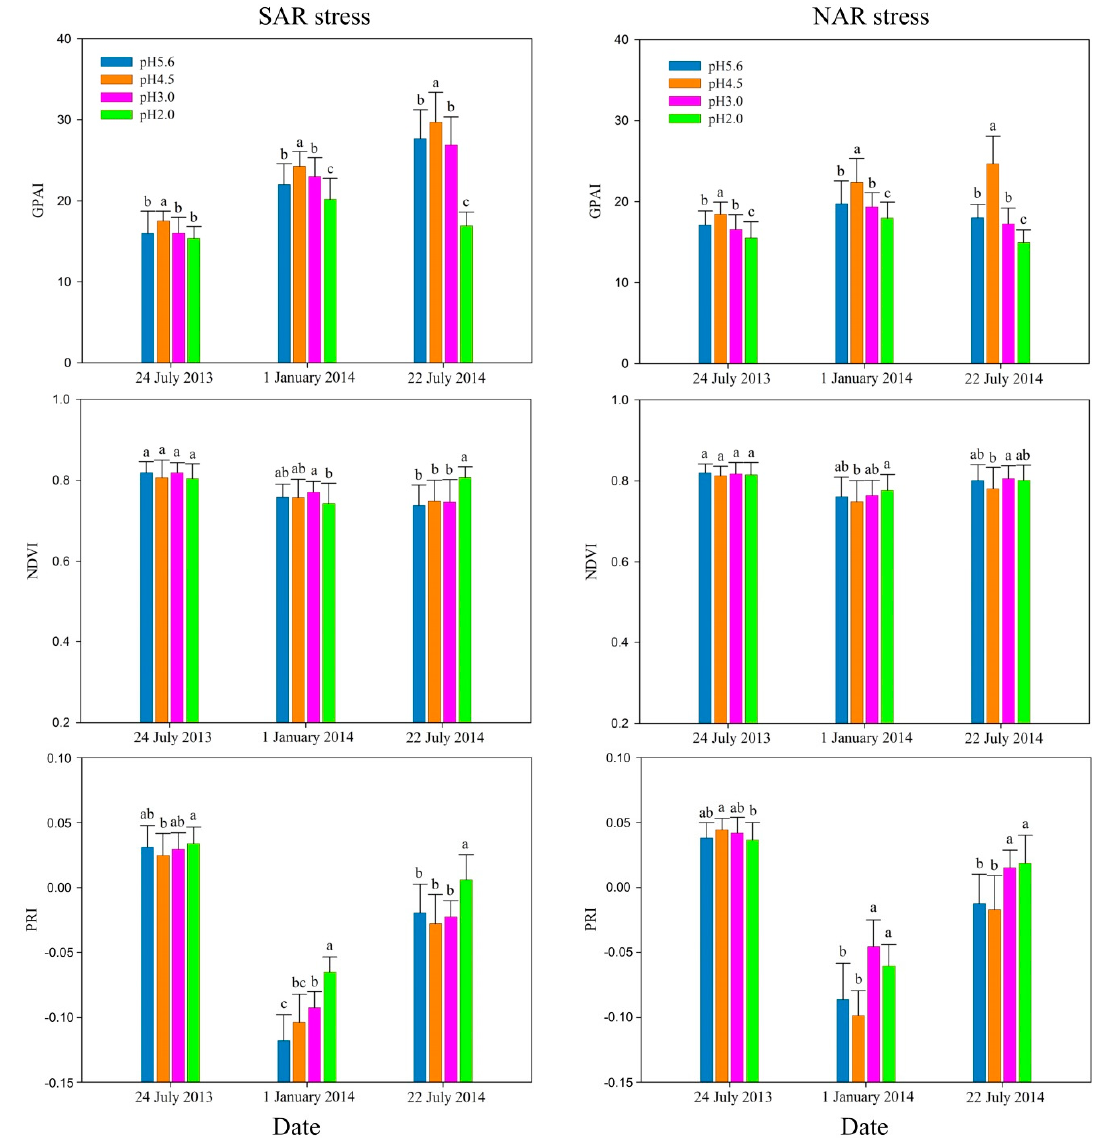
Figure 2. The difference of green peak area index (GPAI), normalized difference vegetation index (NDVI) and physiological reflectance index (PRI). Different letters above the columns indicates statistically significant difference ( p < 0.05) among treatments according to LSD test results.